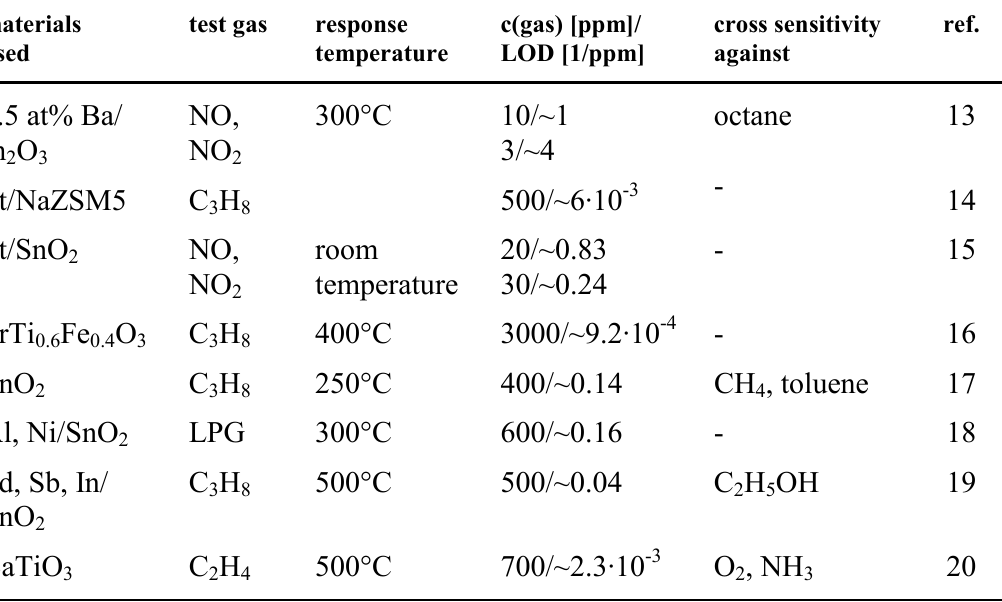
Table 1. Figures of merits of comparable sensors for nitrogen oxides and short-chained hydrocarbons.